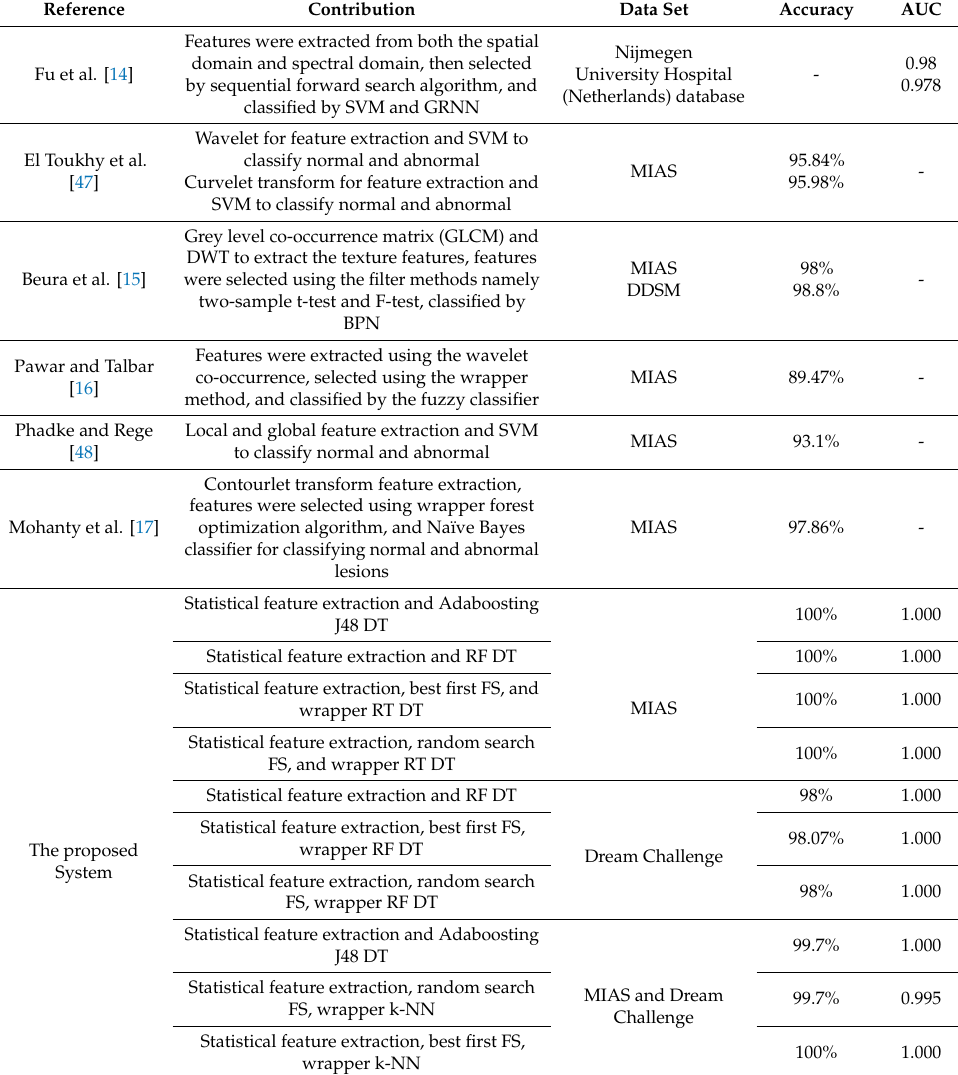
Table 11. Classification results for di ff erent breast classification methods using di ff erent classifiers.